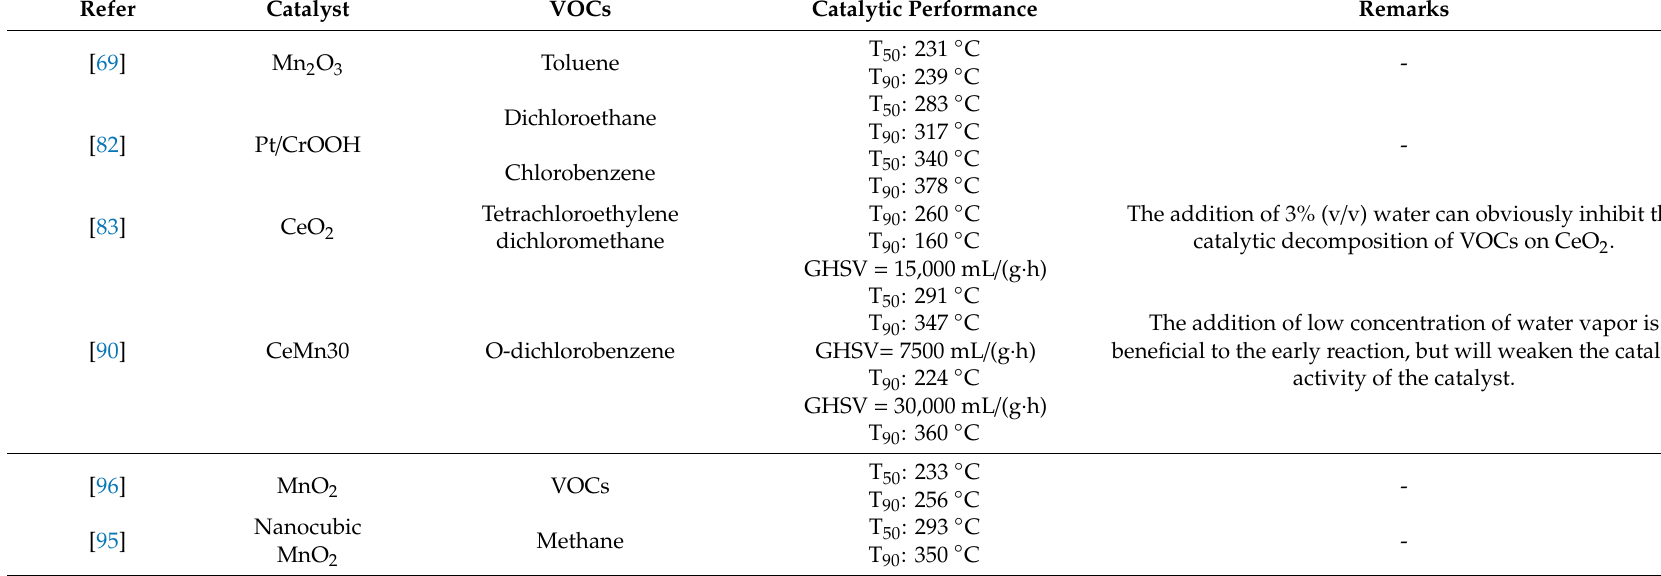
Table 6. Non-noble metal catalysts for catalytic combustion of